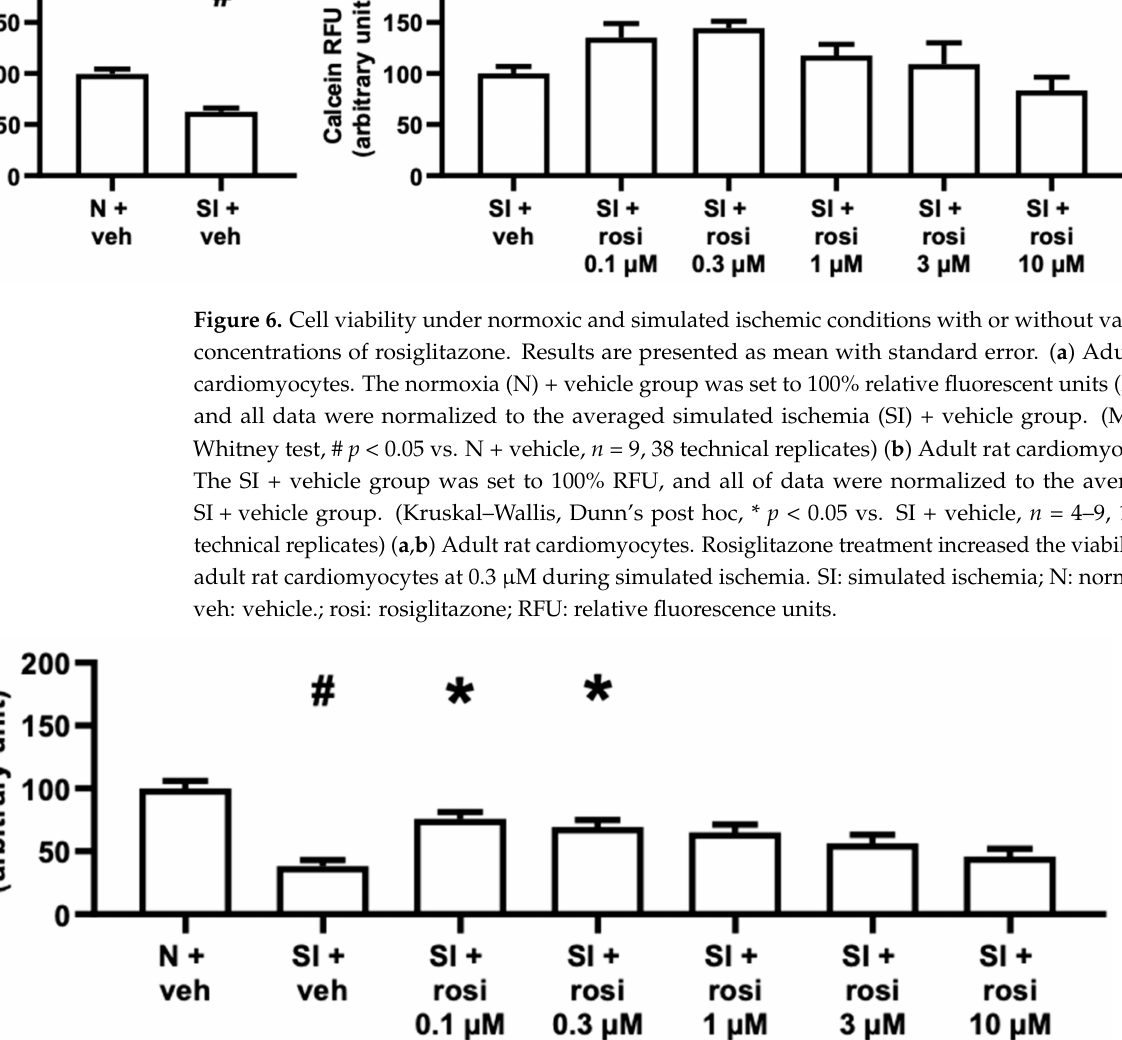
Figure 7. AC16 cell line viability under normoxic and simulated ischemic conditions with or without varying concentrations of rosiglitazone. Results are presented as mean with standard error. The N + vehicle group was set to 100% RFU, and all data were normalized to the averaged N + vehicle group. Rosiglitazone treatment increased the viability of AC16 cells at 0.1 µ M and 0.3 µ M during simulated ischemia. (Kruskal–Wallis, Dunn’s post hoc, * p < 0.05 vs. SI + vehicle, # p < 0.05 vs. N + vehicle, n = 4, 32–39 technical replicates). SI: simulated ischemia; N: normoxia; veh: vehicle; rosi: rosiglitazone; RFU: relative fluorescence